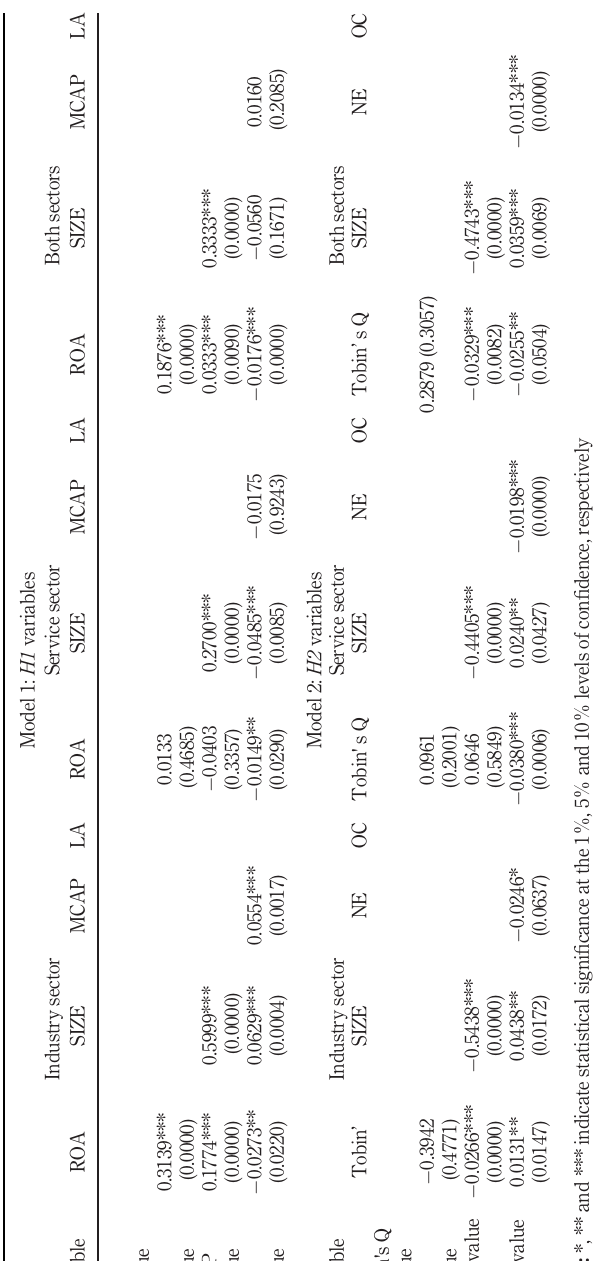
Table III. Pearson